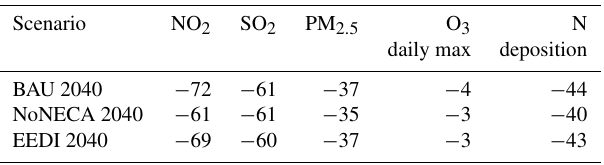
Table 5. Summary of overall changes in future scenarios. Changes (in percent) in spatial average for all future scenarios compared to the present day (simulations with all emissions): annual means of NO 2 , SO 2 , PM 2 . 5 and the daily maximum O 3 within the 4km res- olution area (CD04 grid domains) and annual sum of nitrogen de- position to seawater.